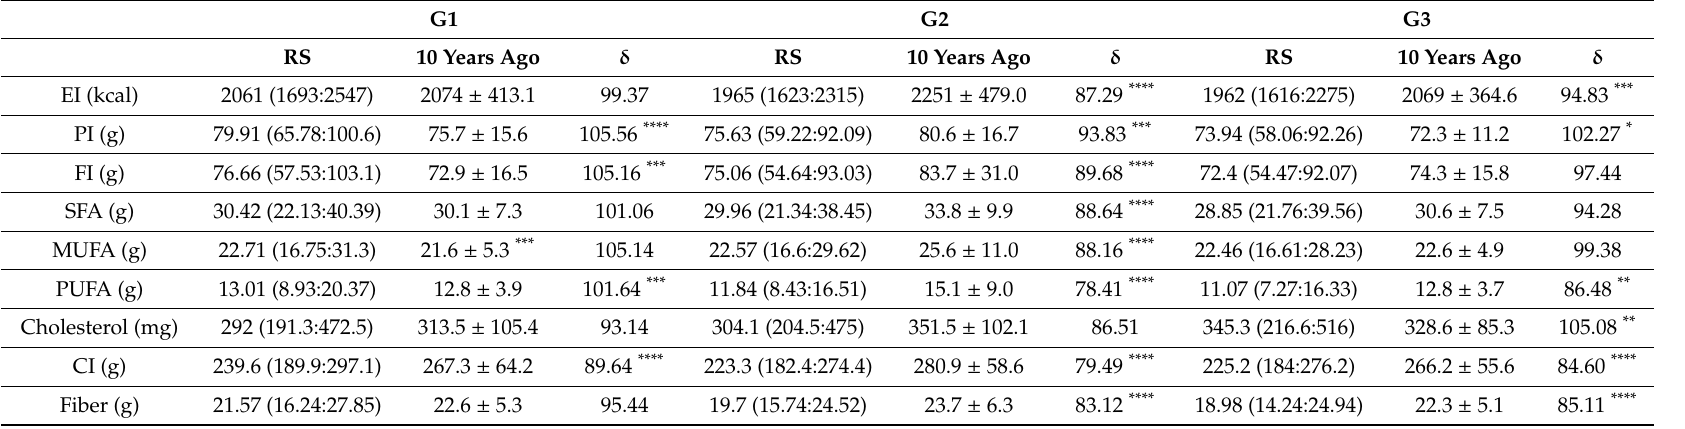
Table 3. The comparison of energy and macronutrients intakes with values ten years